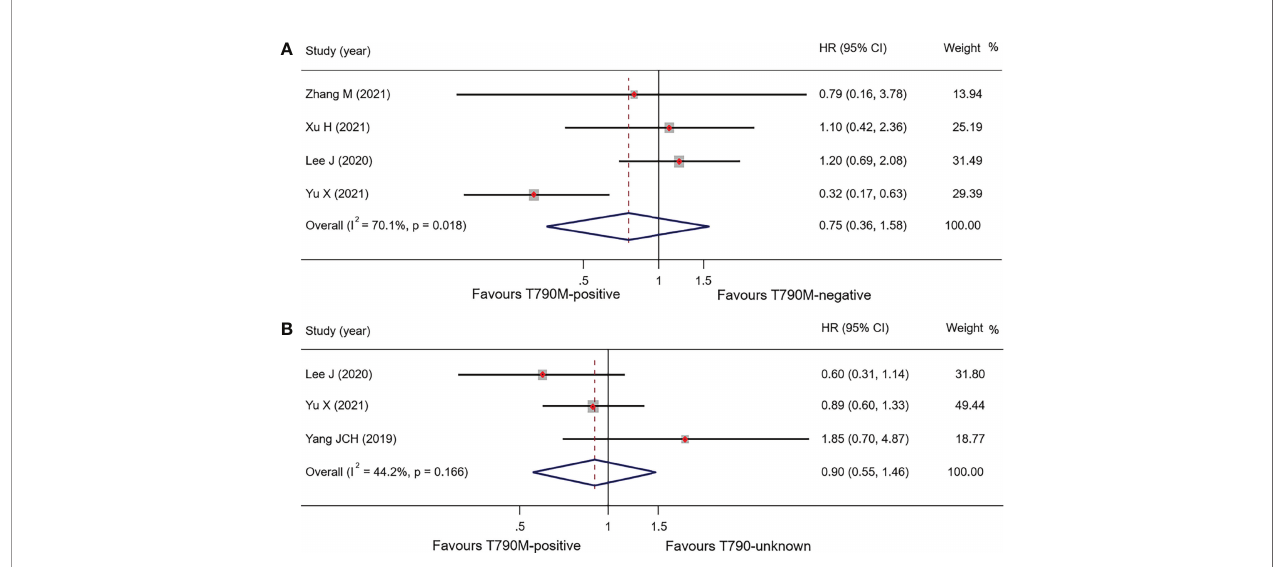
FIGURE 4 | Comparison of BM patients based on T790M mutation status of OS (A) , forest plot of comparison of T790M-positive and T790M-negative (B) , and forest plot of comparison of T790M-positive and T790M-unknown